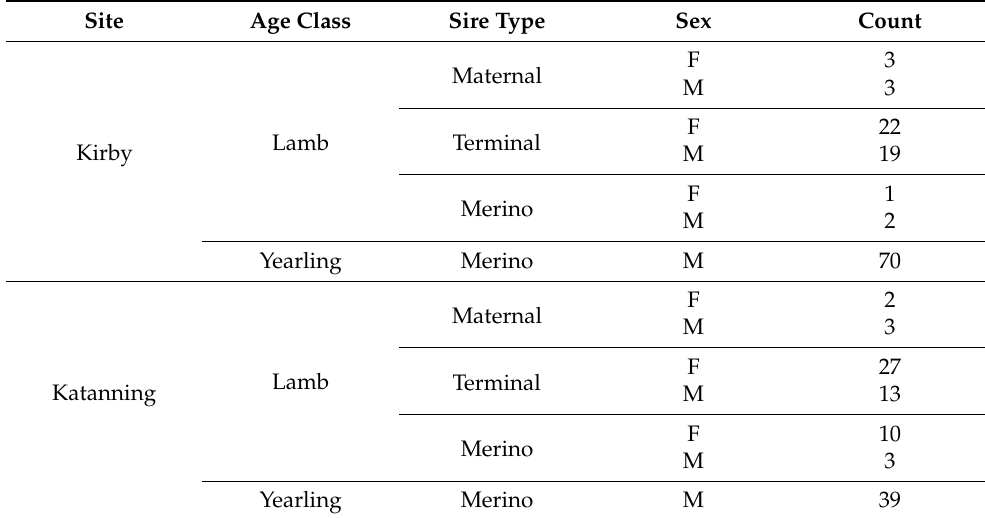
Table 1. Number of lambs and yearlings included in the base models (n = 217), categorised by site, age class, sire type and